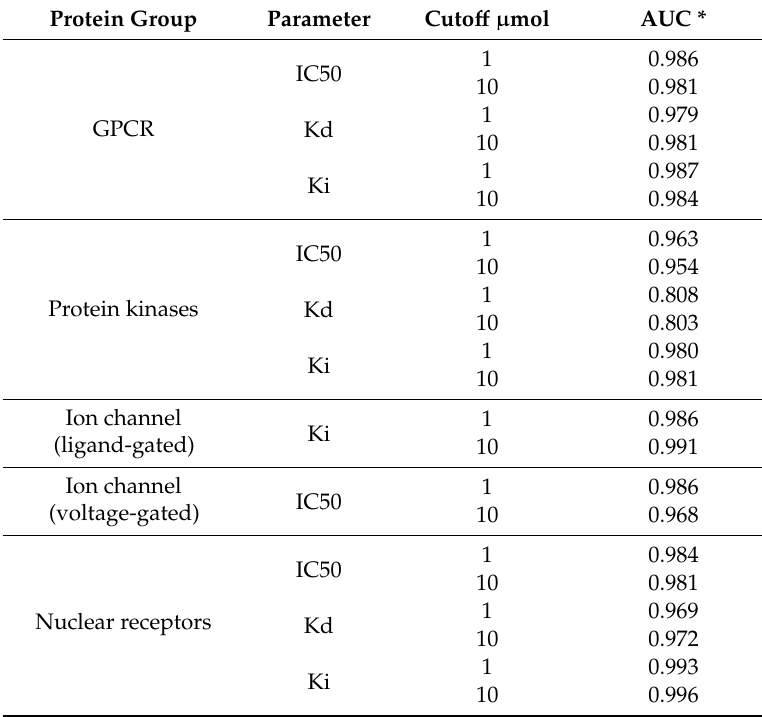
Figure 1. Scenarios simulating prediction of new ligands for known proteins ( a ), new targets for known ligands ( b ), and the interaction between new ligands and new targets ( c ). Table 2. Predictive accuracy for ligands’ a ffi nities to proteins (first